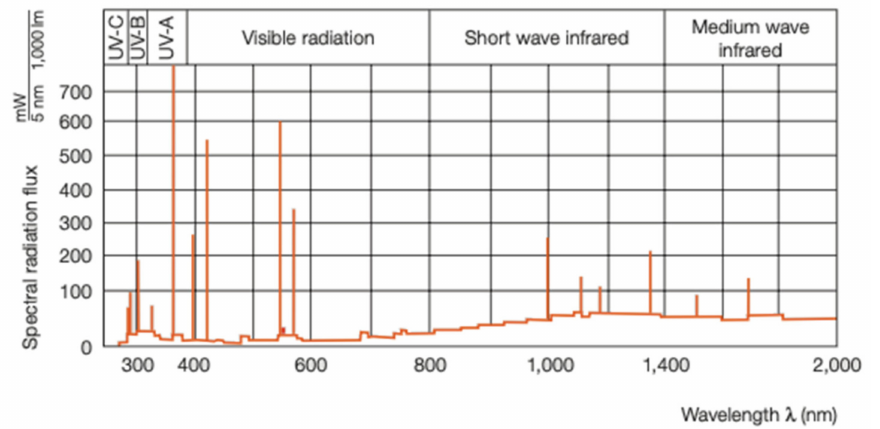
Figure 5. Spectral distribution of the OSRAM Ultra-Vitalux 300W lamp used. Reprinted with permission from ref. [45]. Copyright 2019 Elsevier and Copyright Clearance